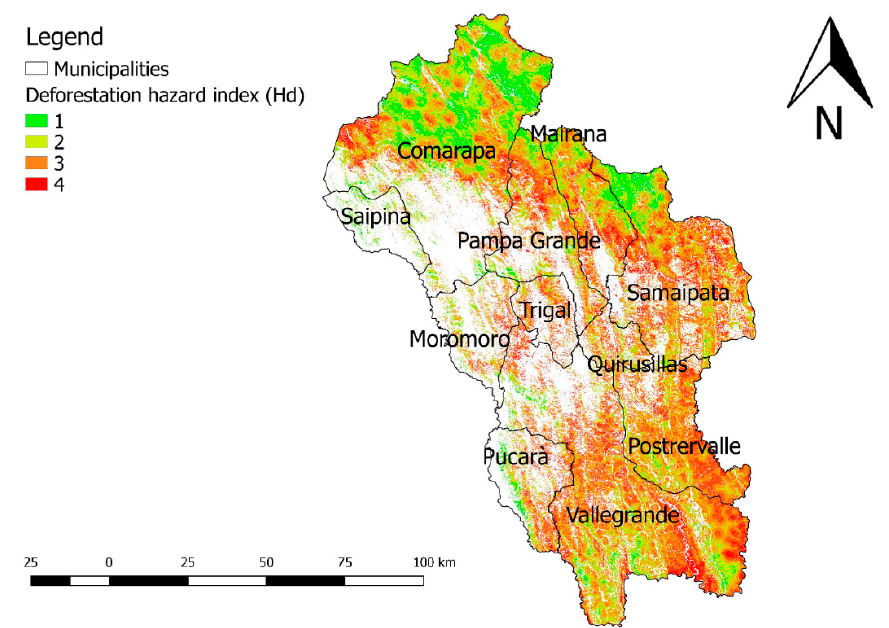
Figure 4. Deforestation hazard map (Hd) of the “Valles Cruceños” region. Hd varies from 1 (lower) to